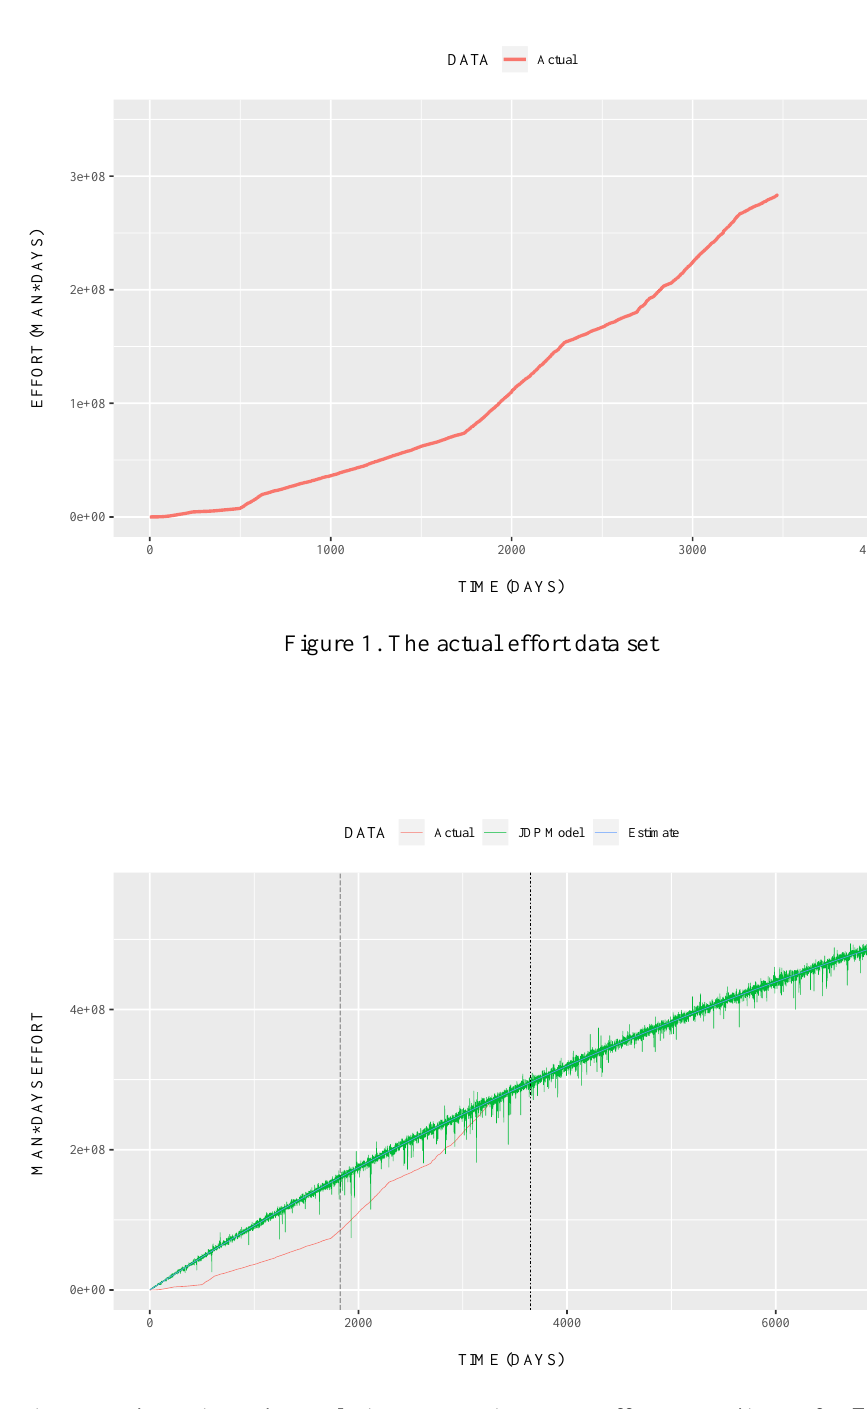
Figure 2. The estimated cumulative OSS maintenance effort expenditures for 𝐸